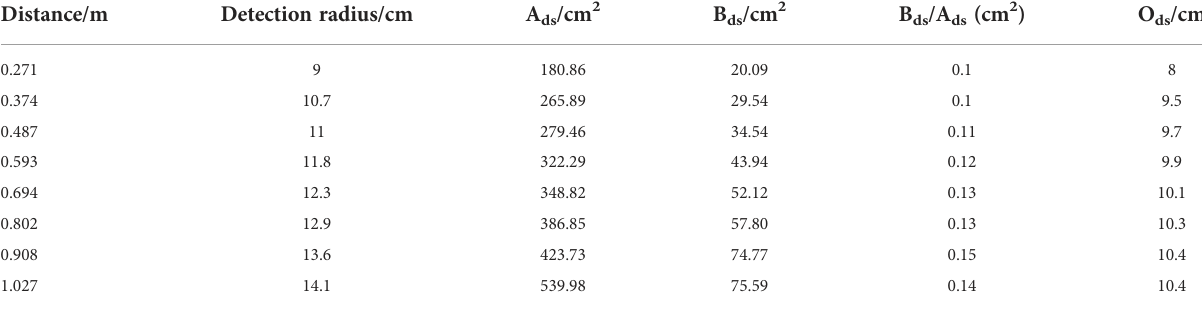
TABLE 3 Switching of detection values at steps for different detection heights. Distance/m